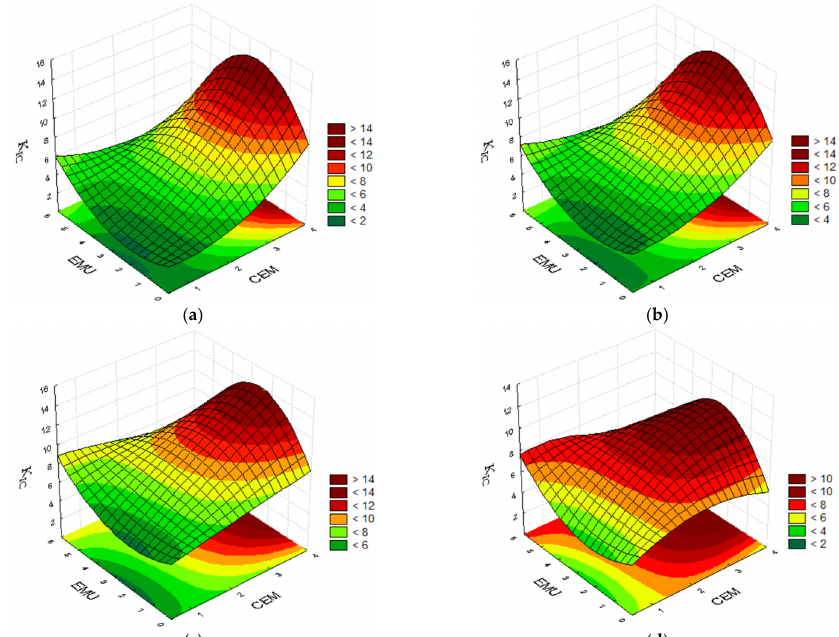
Figure 8. Plots for fracture toughness K IC at the temp. of 0 °C, taking into consideration the cement and bitumen emulsion contents and the polymer emulsion content of ( a ) 0.0%; ( b ) 0.5%; ( c ) 2.0%; and ( d ) 3.5%. With no minimum polymer content in the mixture, the highest fracture toughness can be achieved for formulae containing more than 3.0% of cement and 2.5% of bitumen emulsion. An increase in the polymer content to 2.0% allows us to reduce the cement content in the mixture while maintaining a high fracture resistance. The addition of 3.5% of polymer enables a substantial reduction in the content of cement and bitumen emulsion contents, thereby allowing us to achieve a high fracture resistance of the recycled mixture even with 1.0% of emulsion and 2.0% of cement. When the test temperature is increased to 20 °C, it is possible to observe the significance of the mixture’s polymer content. The highest fracture toughness was achieved by the mixture containing 3.5% of cement, 0.5% of polymer, and 2.5% of bitumen emulsion. The subbase containing no bitumen emulsion, 2.0% of cement, and 3.5% of modifier achieved a very good result. Two mixtures achieved a similar fracture resistance